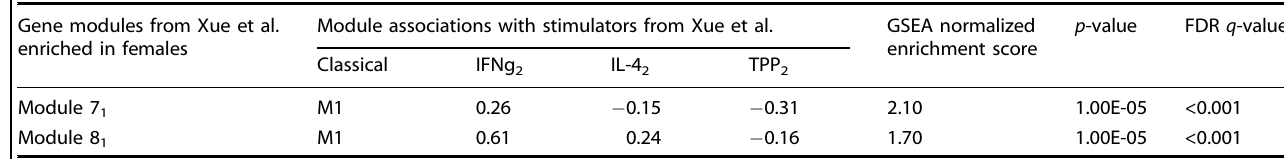
Table 2. Monocyte activation state modules signi fi cantly enriched between PD vs HC subjects in females. Gene modules from Xue et al. Module associations with stimulators from Xue et enriched in females